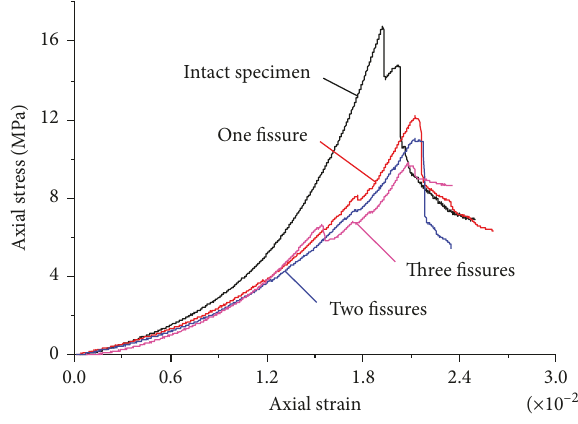
Figure 4: Axial stress-strain curves of layer-crack specimens with different fissure numbers. Table 1: Test results of basic mechanical properties of layer-crack specimens under uniaxial compression. Type of